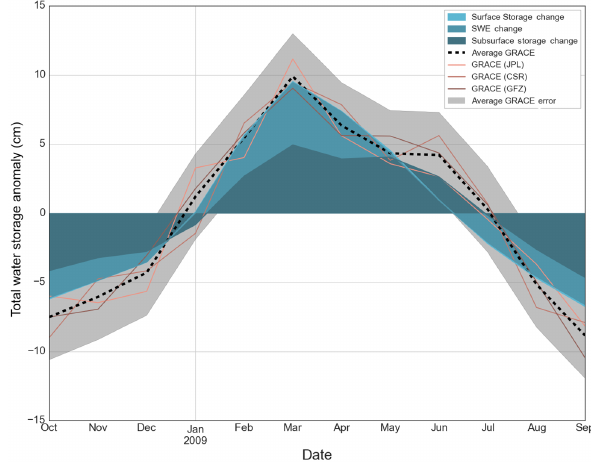
Figure 6. Total terrestrial water storage (TWS) comparison between GRACE (dashed, solid lines, gray area) and the San Joaquin Basin model (blue-filled areas). Simulated annual amplitude in storage change is lower than that derived from the GRACE signal. This dis- crepancy can be attributed to precipitation shortfalls in the forcing dataset and lack of pumping, irrigation, and surface retention in the